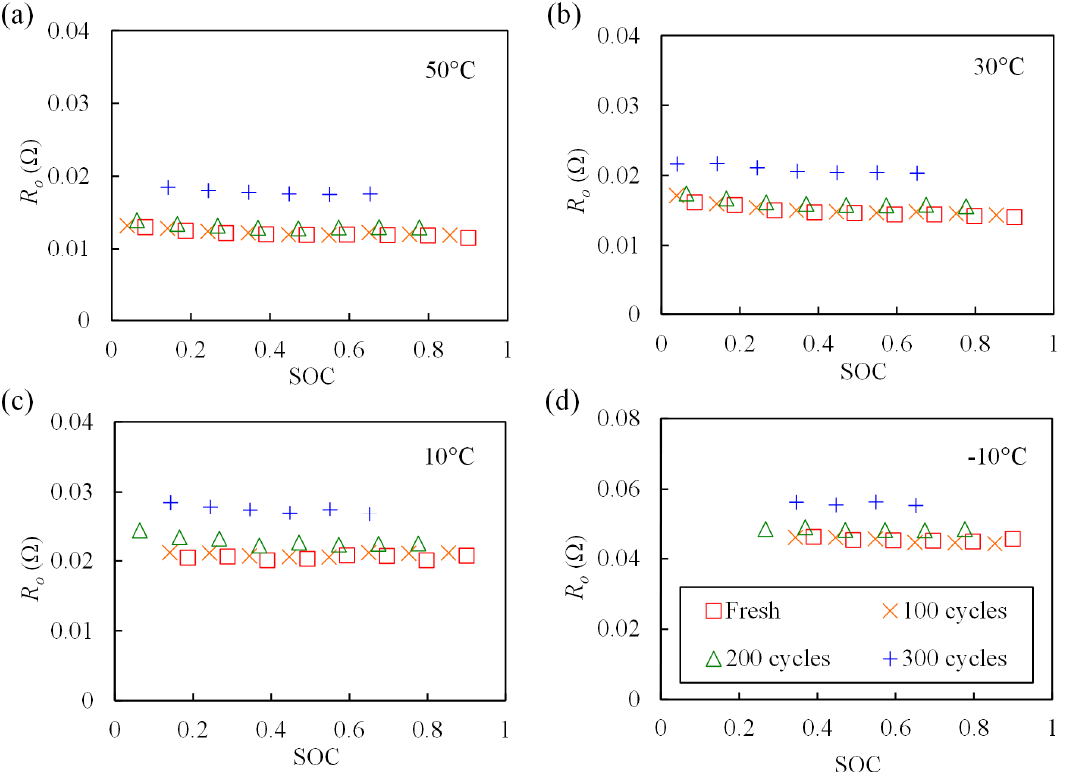
Figure 4. R o values of different aging cycles at various temperatures: ( a ) 50 °C; ( b ) 30 °C; ( c ) 10 °C; ( d ) − 10